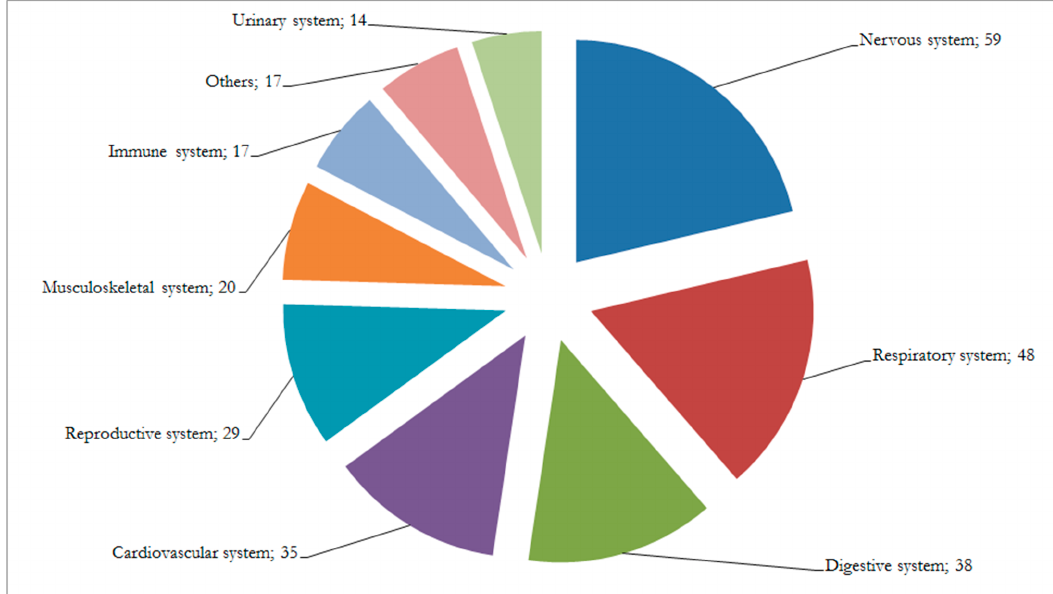
Figure 3. Factor diagram of disease categories in the East Rhodopes, according to the number of mentions Σ U .